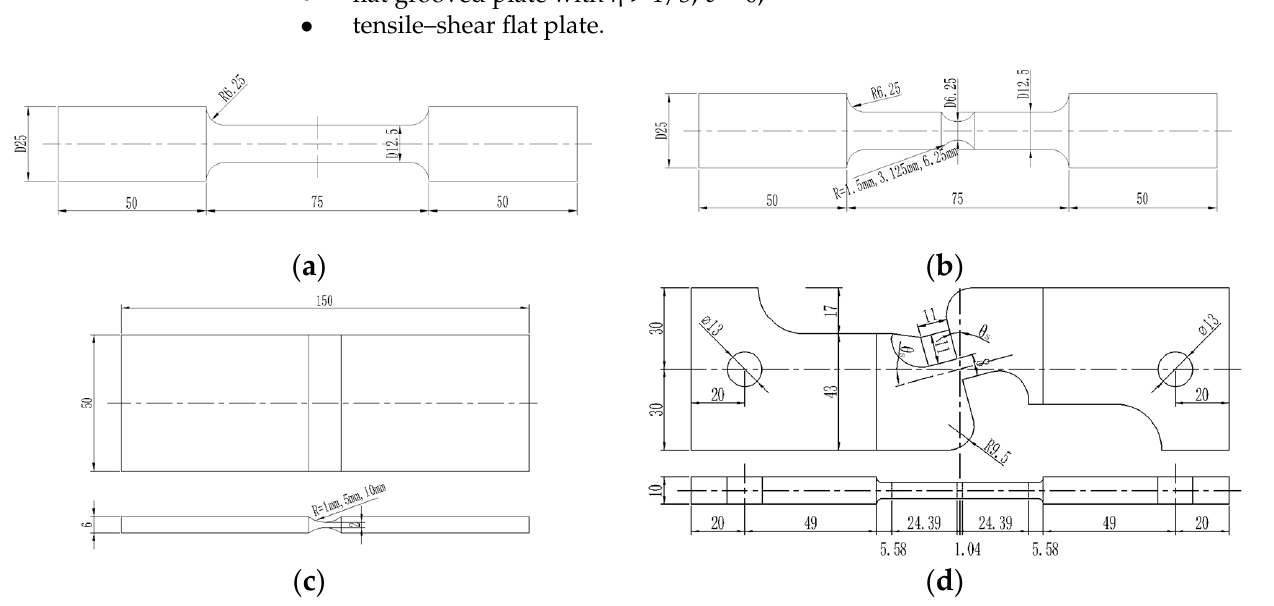
Figure 1. Geometries of the test specimens (dimensions in millimeters): ( a ) smooth round bars, ( b ) notched round bars, ( c ) flat grooved plates, ( d ) tensile–shear flat plates.